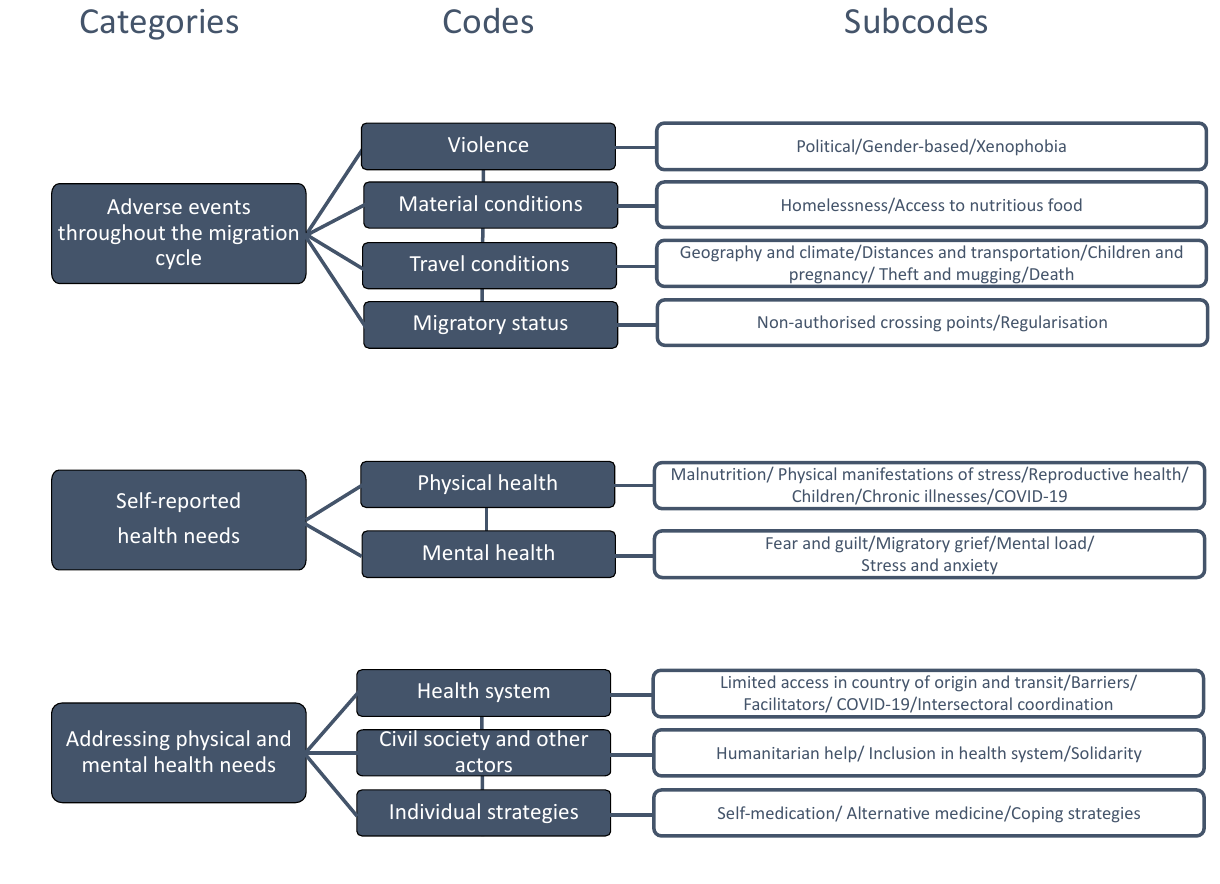
Figure 1. The study’s coding tree.